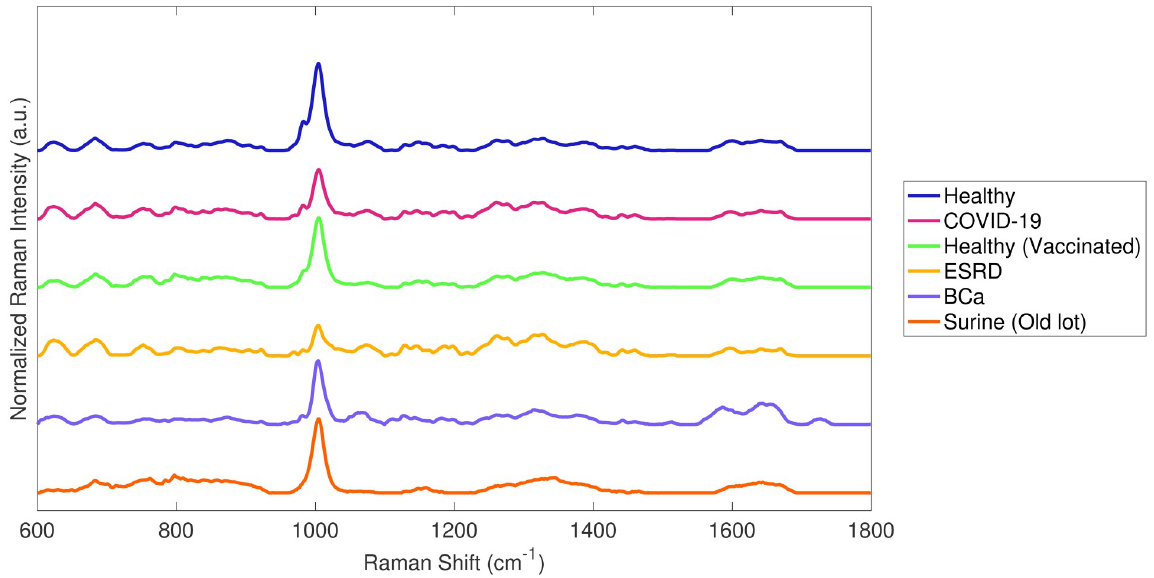
Fig 2. Averages of ISREA baselined and vector normalized spectra for classes specified in Table